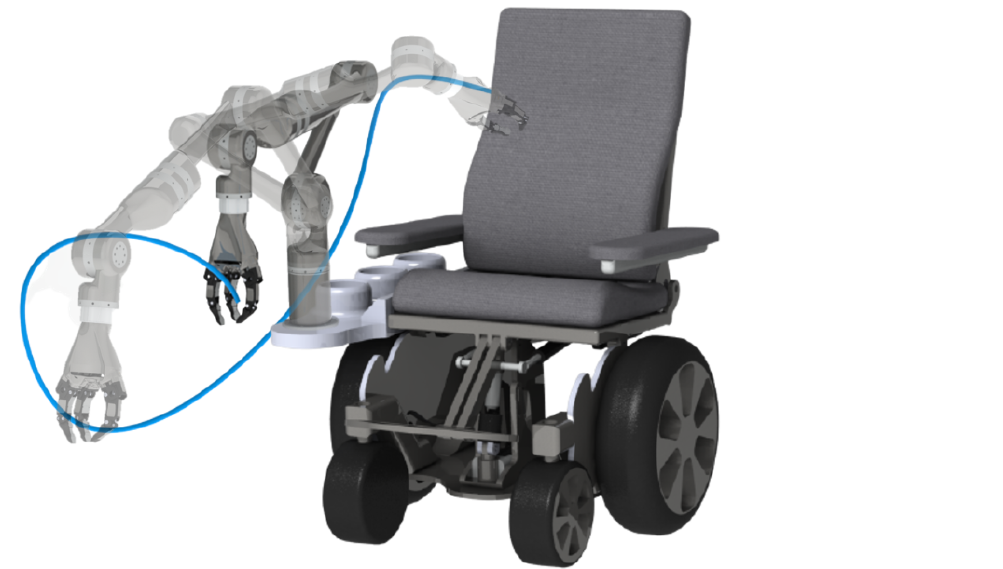
Figure 8. Trajectory for testing the assumption of static torque instead of dynamic